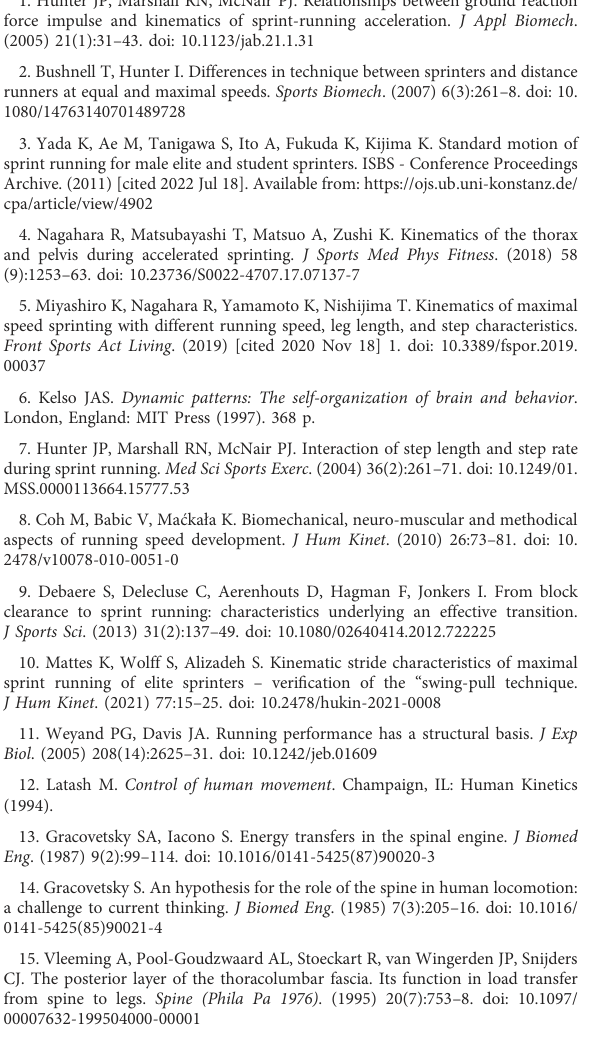
SUPPLEMENTARY FIGURE S5 SCR for PC 11 A) Sagittal plane view B) Frontal plane view C) Transverse plane view. The blue avatar represents the 5th percentile (slow), black represents the mean and red represents the 95th percentile (fast). SUPPLEMENTARY FIGURE S6 SCR for PC 12 A) Sagittal plane view B) Frontal plane view C) Transverse plane view. The blue avatar represents the 5th percentile (slow), black represents the mean and red represents the 95th percentile (fast). SUPPLEMENTARY FIGURE S7 SCR for PC 13 A) Sagittal plane view B) Frontal plane view C) Transverse plane view. The blue avatar represents the 5th percentile (slow), black represents the mean and red represents the 95th percentile (fast). SUPPLEMENTARY FIGURE S8 SCR for PC 16 A) Sagittal plane view B) Frontal plane view C) Transverse plane view. The blue avatar represents the 5th percentile (slow), black represents the mean and red represents the 95th percentile (fast).